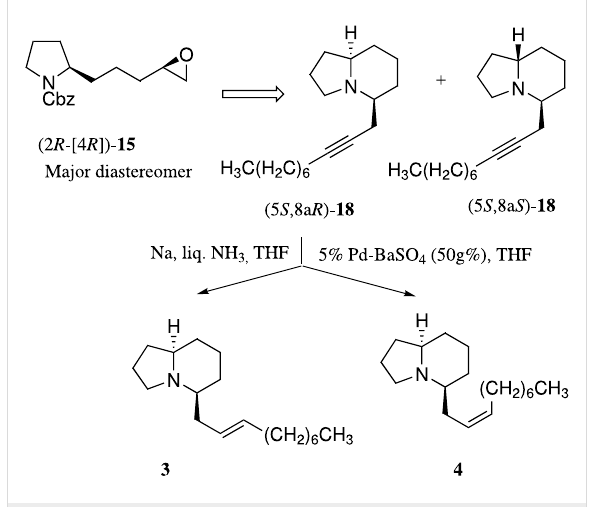
Scheme 4: Asymmetric synthesis of piclavines A3 and A4 from (2 R - [4 R ])- 15